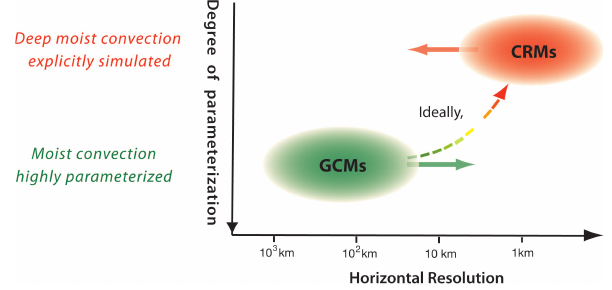
Fig. 2. Two families of atmospheric models with different model